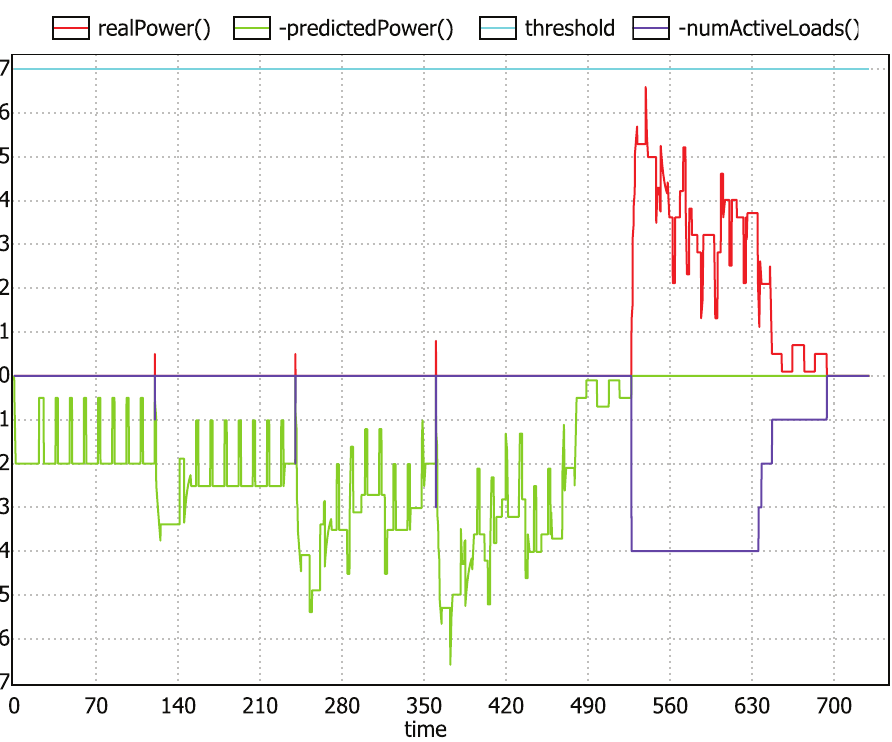
Figure 10. The real and predicted power consumption (in KW) and the number of active loads during load scheduling with a threshold of 7